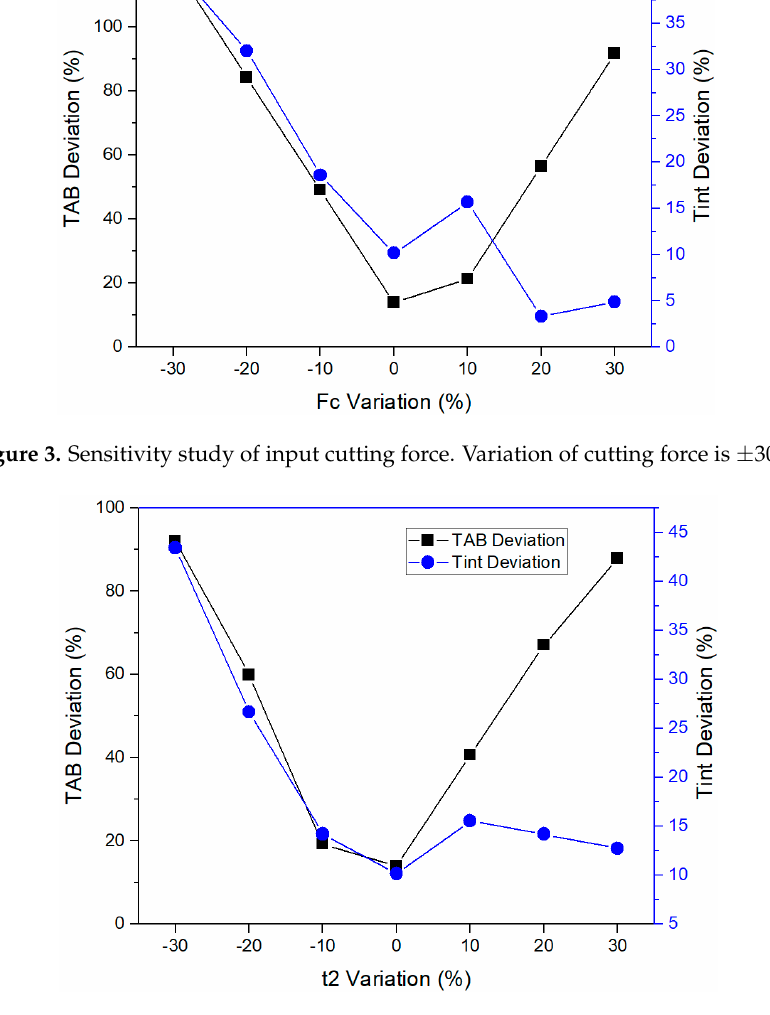
Figure 4. Sensitivity study of input chip thickness. Variation of chip thickness is ±30%.